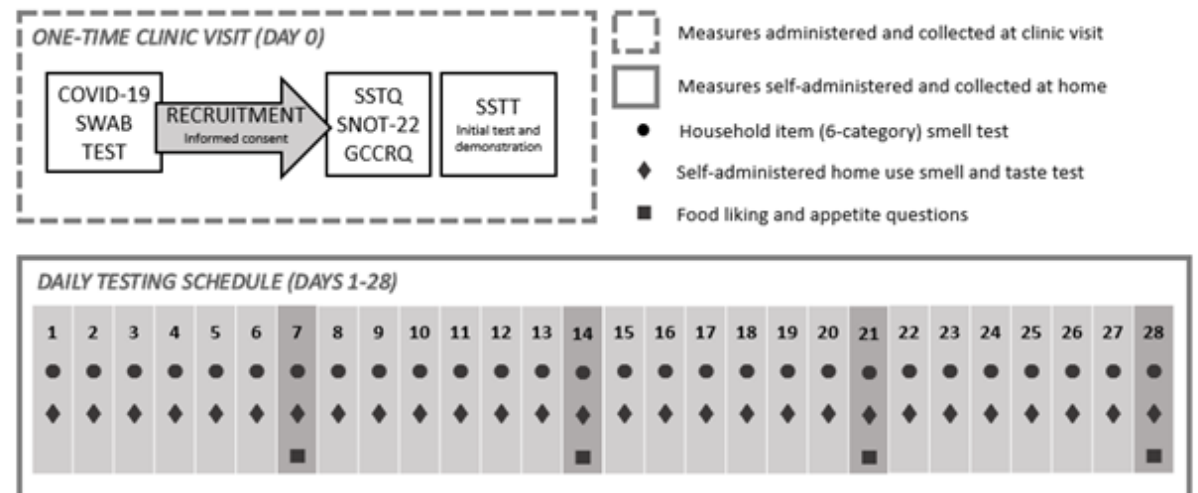
Figure 1. Frequency of the different test measures for the COVOSMIA-19 clinical trial. GCCRQ: Global Consortium for Chemosensory Research Questionnaire; SNOT-22: Sino-Nasal Outcome Test; SSTQ: Singapore Smell and Taste Questionnaire; SSTT: Singapore Smell and Taste